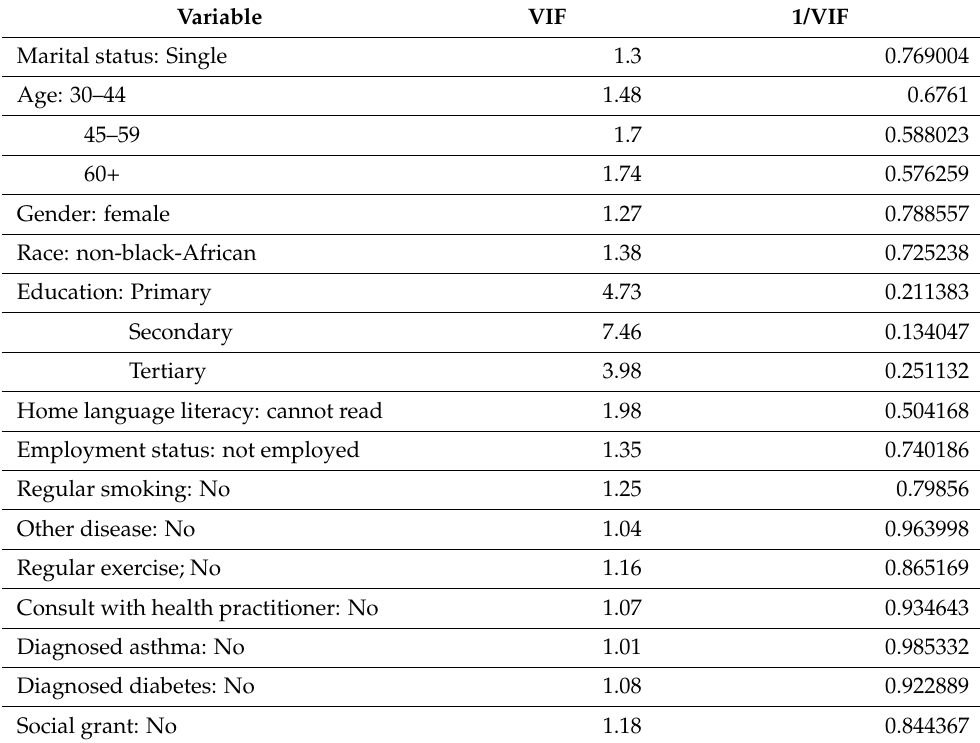
Table 1. Results obtained using Multicollinearity